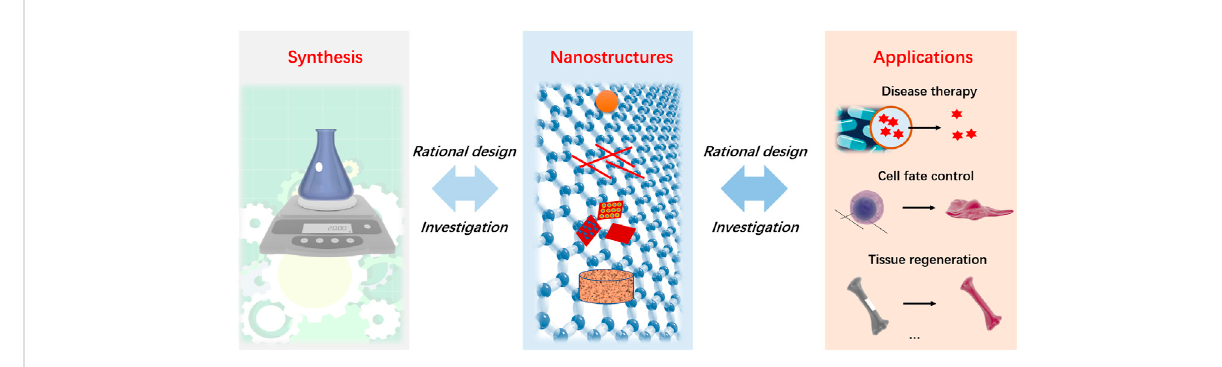
FIGURE 1 Overview of design, preparation and applications of nanostructured